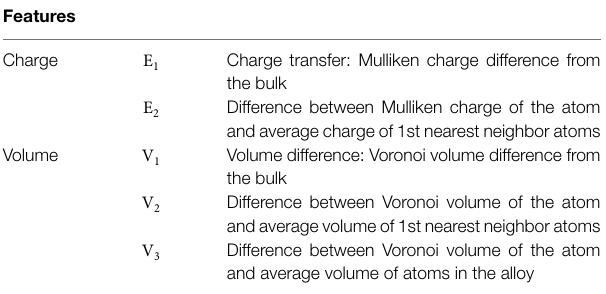
TABLE 3 | List of features used for the random forest method. Features